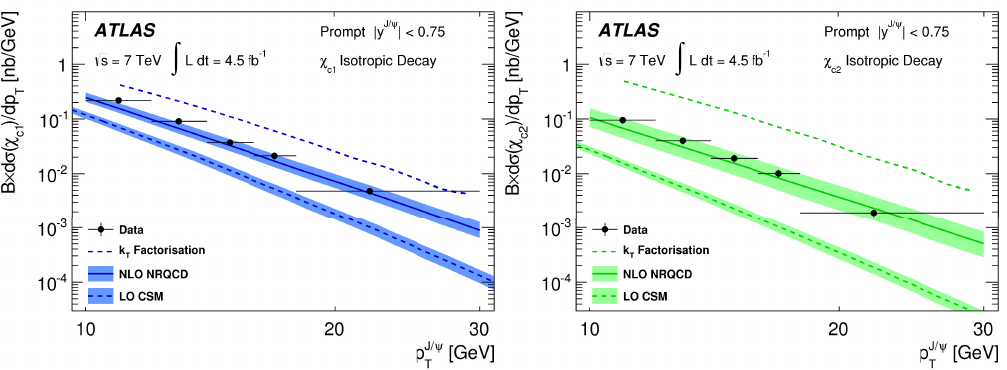
be dominated by CS (Fig. 2, right). However, both of the leading order (LO) CS and next-to-leading order (NLO) CO predictions are compatible with the measured result at the 2 σ level.